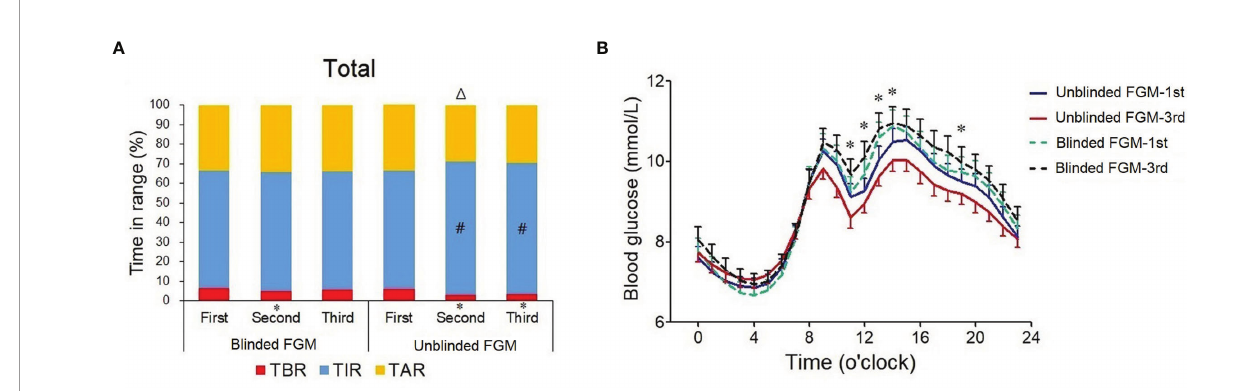
FIGURE 2 | Changes in daily glycemic control during three fl ash glucose monitorings in professional and unblinded FGM groups. (A) Percentage time in the target range of 3.9 – 10.0 mmol/l (TIR) during the fi rst (baseline, blinded FGM in both groups), second (days 31 – 45), and third (days 76 – 90) FGM in the blinded FGM group (n = 89) and unblinded FGM group (n = 83), blue bar; time below the target range (TBR), red bar; time above the target range (TAR), yellow bar. Data are percentage; #, vs. fi rst FGM, p value < 0.05. (B) Hourly mean blood glucose during the fi rst and third FGMs. Blue solid line, fi rst FGM in the unblinded FGM group; red solid line, third FGM in the unblinded FGM group; green dotted line, fi rst FGM in the blinded FGM group; black dotted line, third FGM in the blinded FGM group. * p < 0.05 between two groups .